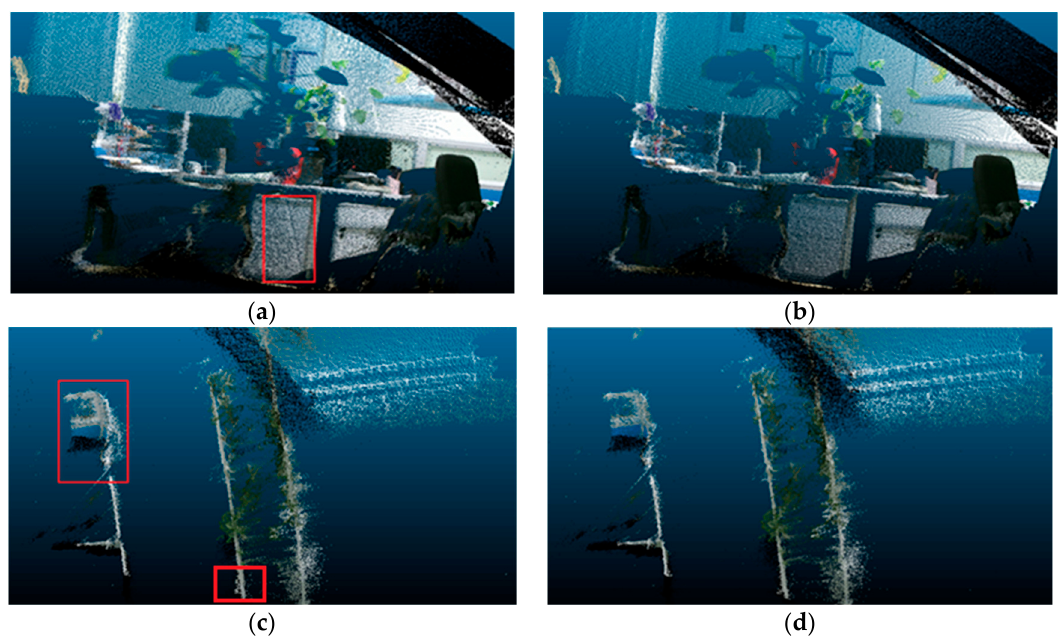
Figure 12. 3D reconstruction before and after depth correction: Reconstruction before depth correction ( a,c ); Reconstruction after depth correction ( b,d ).